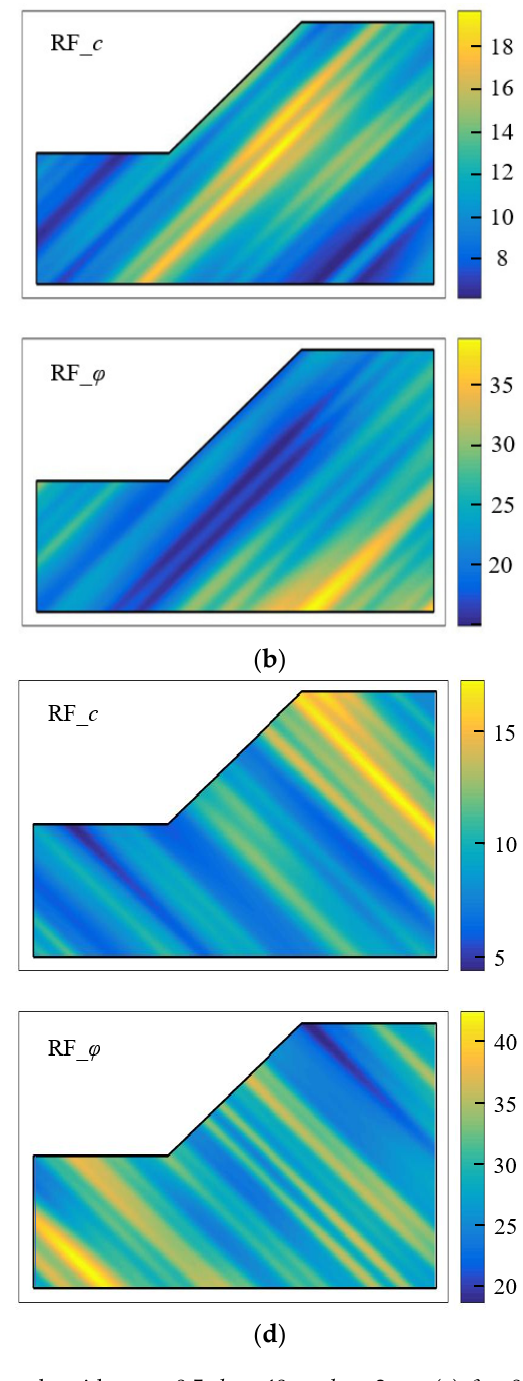
Figure 6. Realizations of random fields of cohesion and friction angle with r = − 0.5; l h = 40 m, l v = 3 m. ( a ) β = 0°; ( b ) β = 45°; ( c ) β = 90°; ( d ) β = 135°.